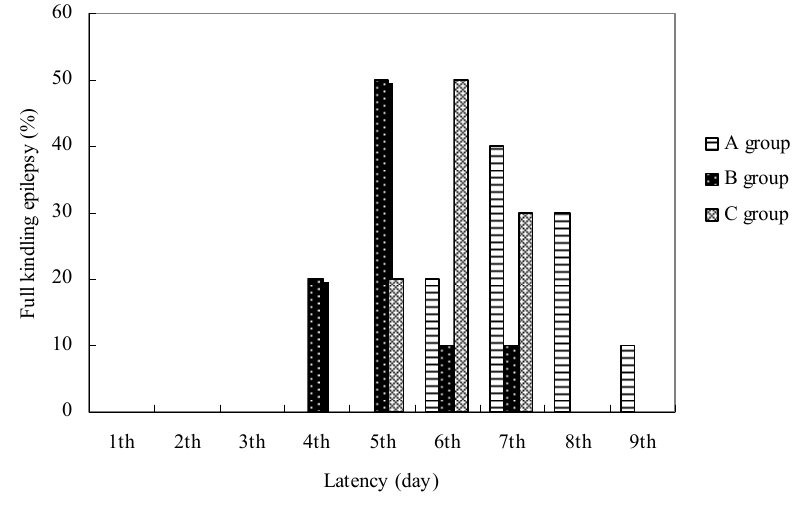
Figure 4. The latent period for development of full kindling